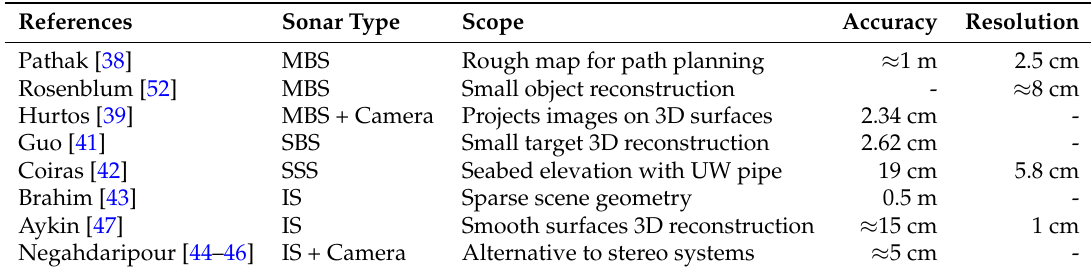
Table 1. Summary of sonar 3D reconstruction